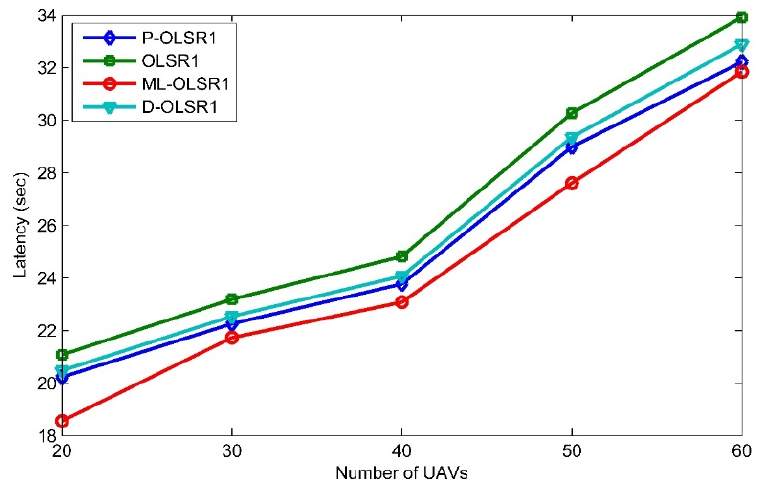
Figure 11. Latency vs. number of UAVs.